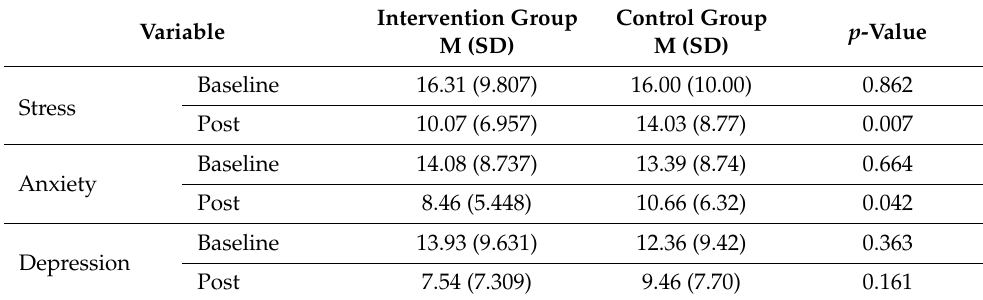
Table 2. Baseline and post-intervention stress, anxiety, and depression of